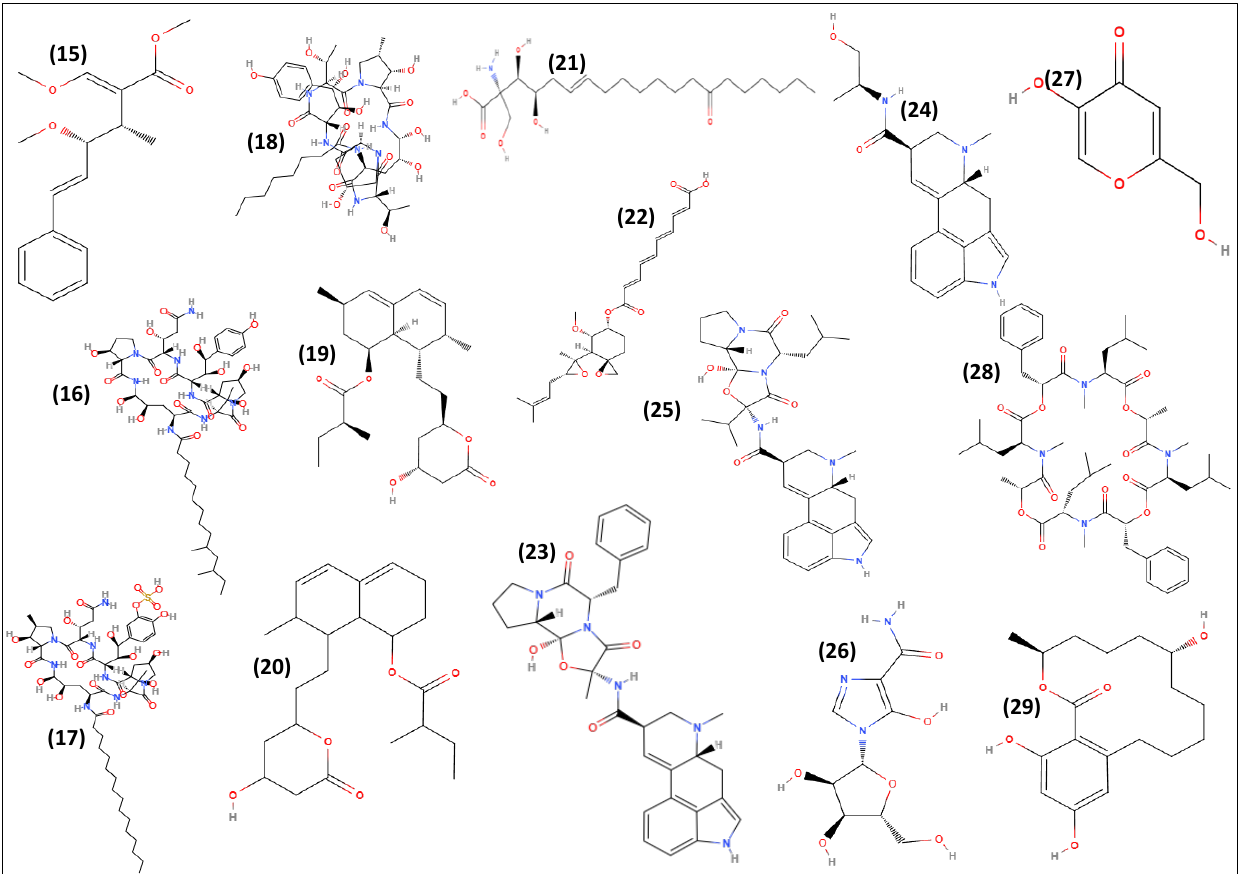
Figure 5. Examples of secondary metabolites from fungi and some of their derivatives successfully applied by pharmaceuticals and agrochemicals industries: (15) pneumocandin B0, (16) FR901379, (17) echinocandin B, (18) enfumafungin, (19) lovastatin, (20) compactin (ML-236B), (21) myriocin (ISP- I), (22) fumagillin, (23) ergotamine, (24) ergometrine, (25) ergocryptine, (26) mizoribine, (27) kojic acid, (28) PF1022A, and (29) α -Zearalanol ( α -ZAL). Structures were obtained from https://molview.org/ (accessed on 2 November